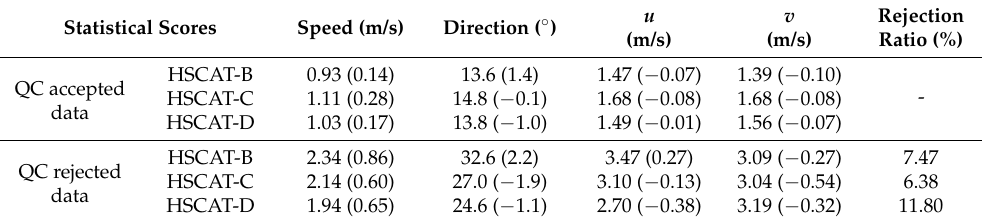
Table 5. The same as Table 3 (w.r.t. buoy winds), but using the above new QC. Statistical Scores Speed (m/s)